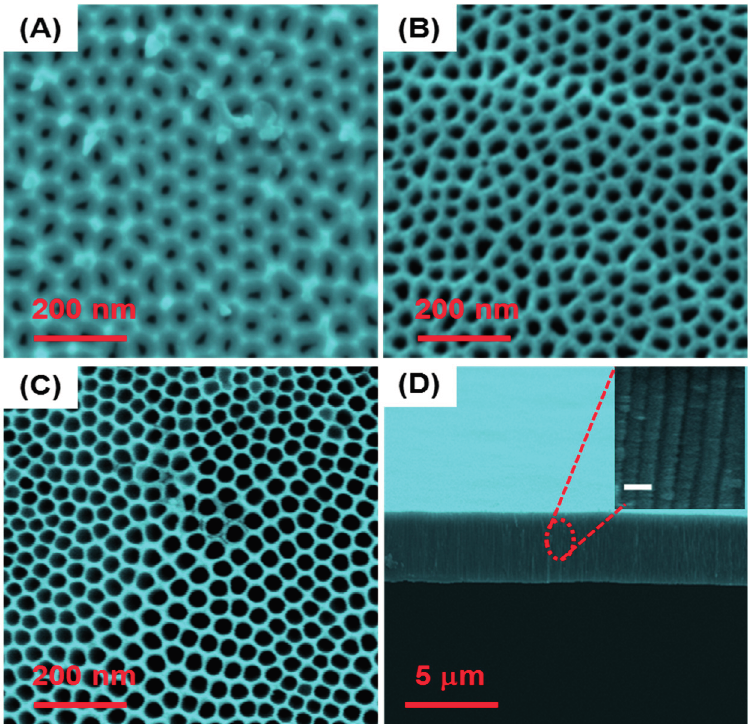
Figure 2. SEM images of the top surface of NPA used as nanopore sensing platform with different pore diameters ( A ) small pore around 25 ± 2 nm ( B ) medium size pore around 45 ± 2 nm ( C ) large pore around 65 ± 2 nm, prepared in 0.3 M oxalic acid electrolyte using different anodization voltages 30–70 V and times between 20 to 180 min to achieve the same pore length ( D ) Cross section SEM images of NPA with the inset figure (scale bar 100 nm) showing well-ordered and aligned pores through the full thickness of the